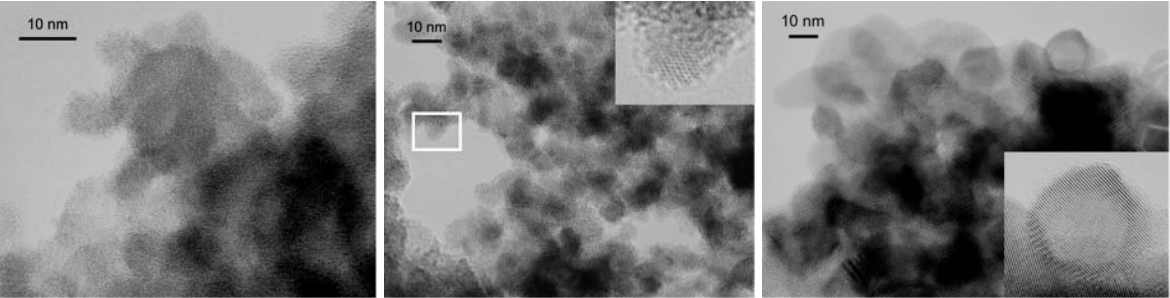
Figure 3. Structure of the metal-oxide sensing layer at the nanoscales, as resulting by Transmission Electron Microscopy (TEM) characterization. As-deposited material ( left ) shows the nanoporous structure generated by soft-assembly of nanoparticles with size below 10 nm. No lattice fringes are visible inside nanoparticles, indicating amorphous structure. After 200 °C annealing ( middle ), material structure evolves towards crystalline order, while particle size and overall porous structure are preserved. After 400 °C annealing ( right ), the crystalline fraction becomes predominant; the porous structure still appears substantially unchanged. Reprinted from